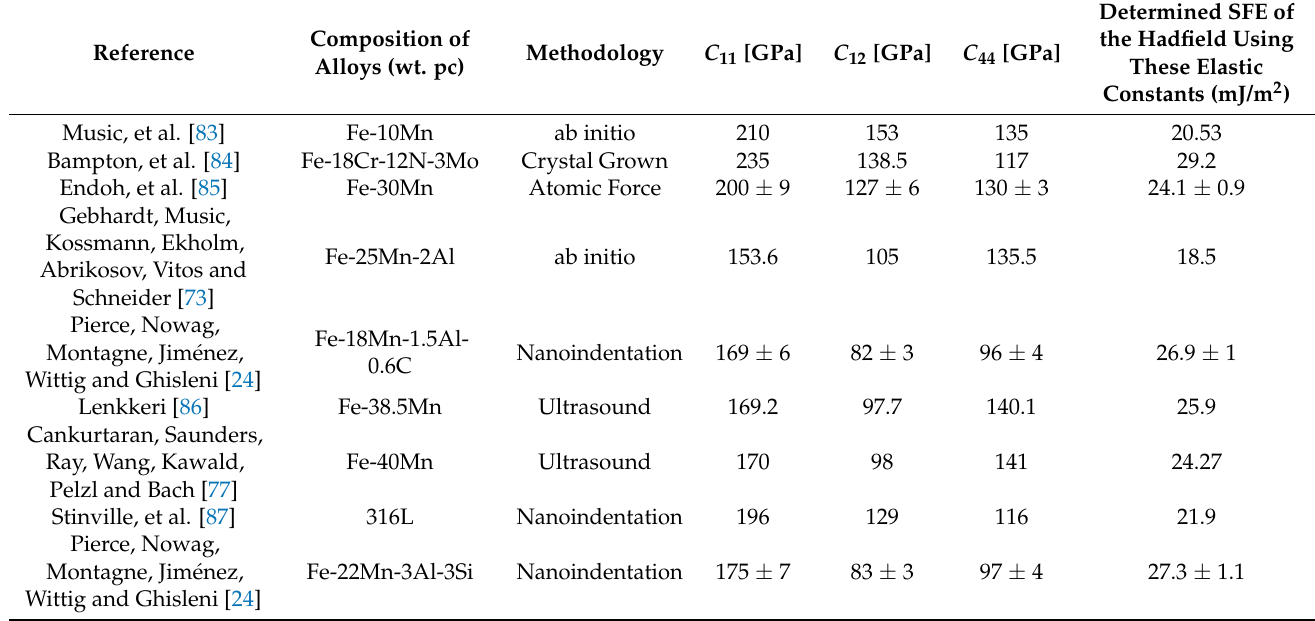
Table 3. SFE of the Hadfield steel (reference sample) for different elastic constant